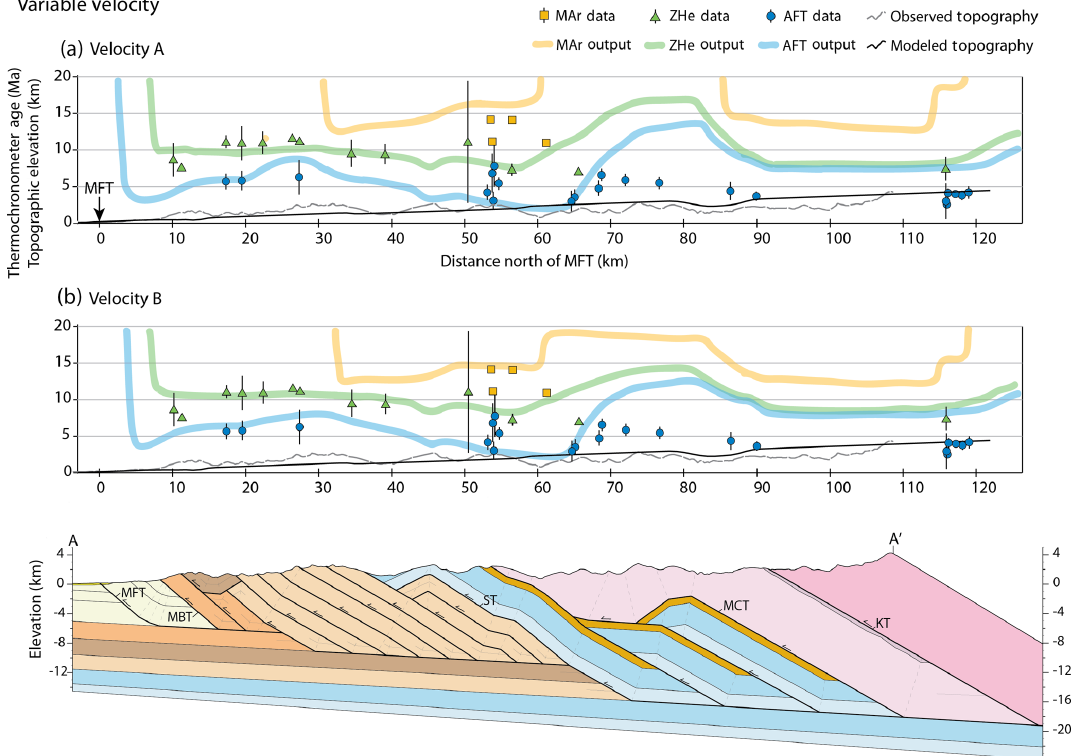
Figure 6. Predicted MAr (yellow), ZHe (green), and AFT (blue) cooling ages using variable velocities (a) and (b) compared to published thermochronometer data. Other model variables are set as Split KT, responsive topography, and A 0 = 2 . 5µWm − 3 .